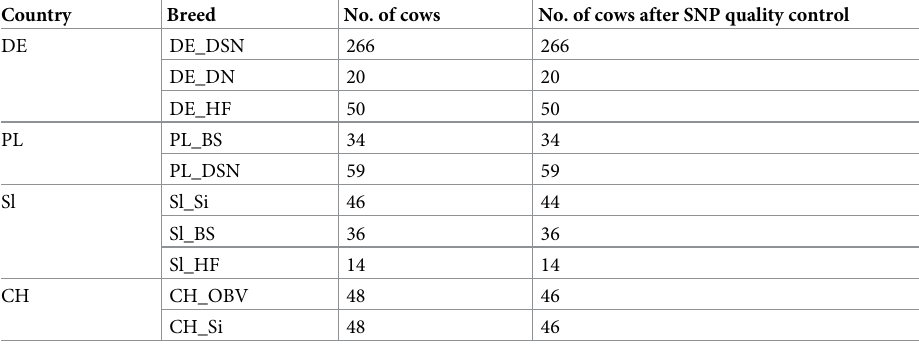
Table 8. Genotype data of five cattle breeds included in PCA, WIDDE and multi-breed GWAS. Country Breed No. of cows No. of cows after SNP quality control DE DE_DSN 266 266